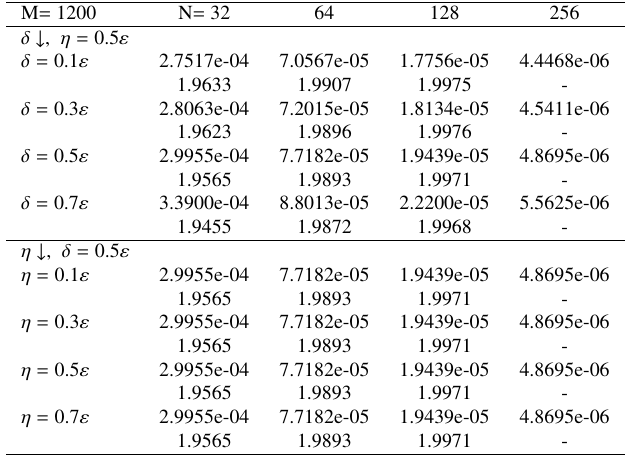
Table 7. Example 4.2, maximum absolute error and rate of convergence for ε = 2 − 2